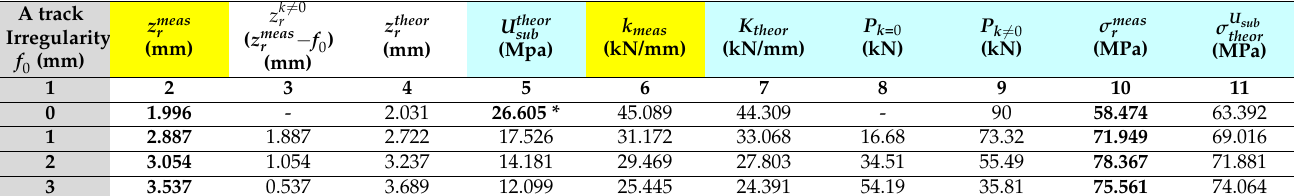
Table 3. The deflection and stress in the rail in a considered section, in consequence of the f 0 irregularity in the track—second axle load for the scheme in Figures 3 and 13.